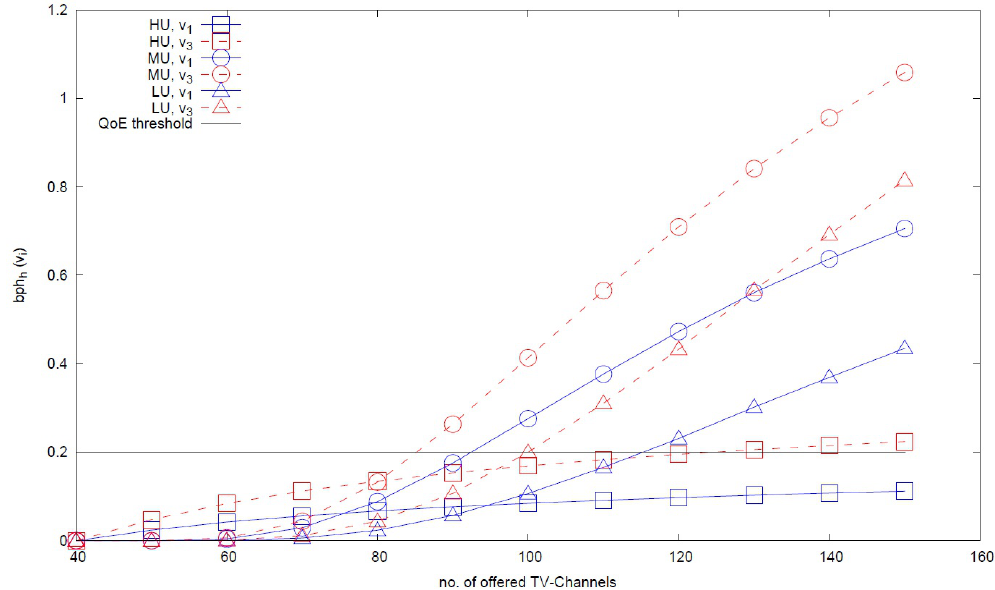
( v ) dependent on the number of offered channels for distinct lanes of Figure 5. bph h i different traffic scenarios in the late period